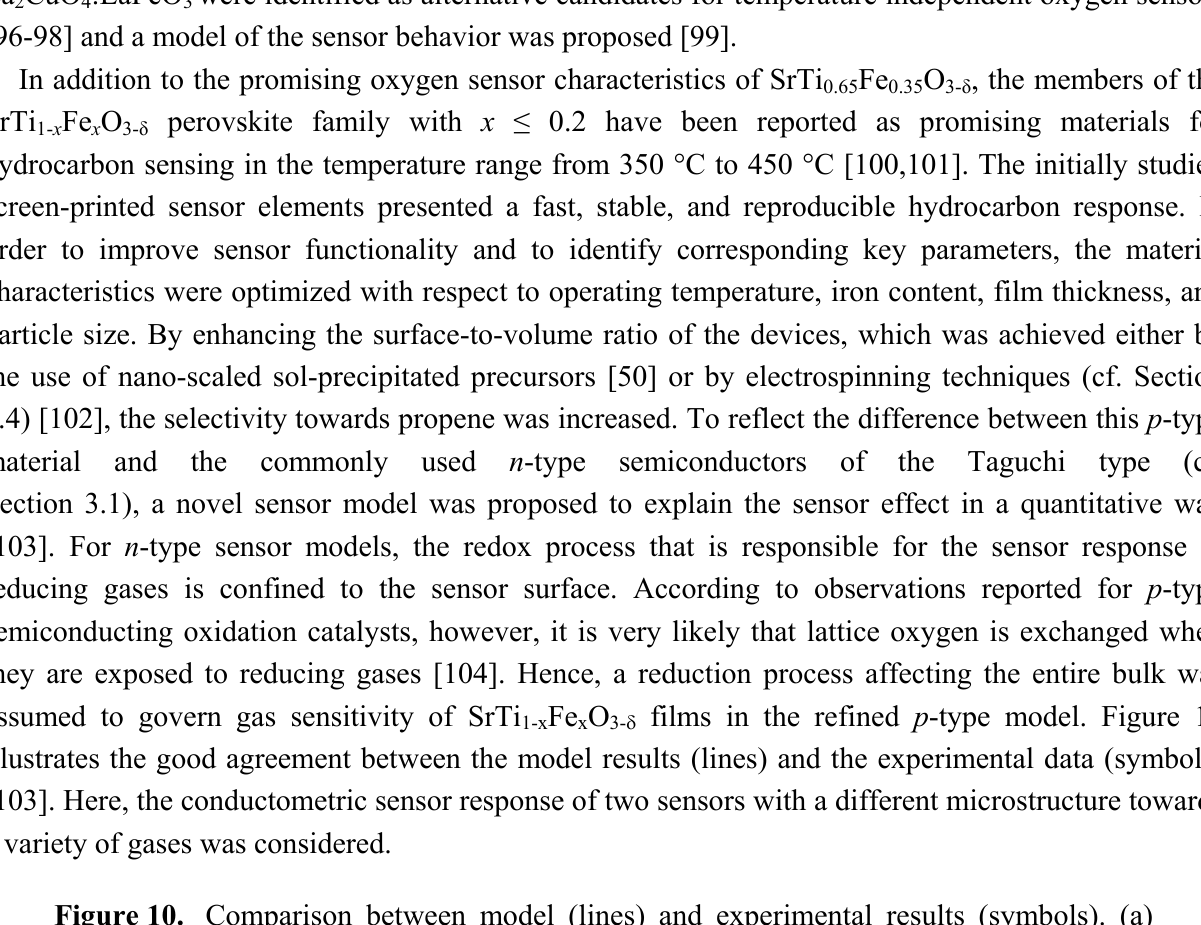
Figure 10. Comparison between model (lines) and experimental results (symbols). (a) Coarse-grained powder, µm scale. (b) Fine sol-precipitated powder, nm-scale (from [103]). Reproduced by permission of the PCCP Owner